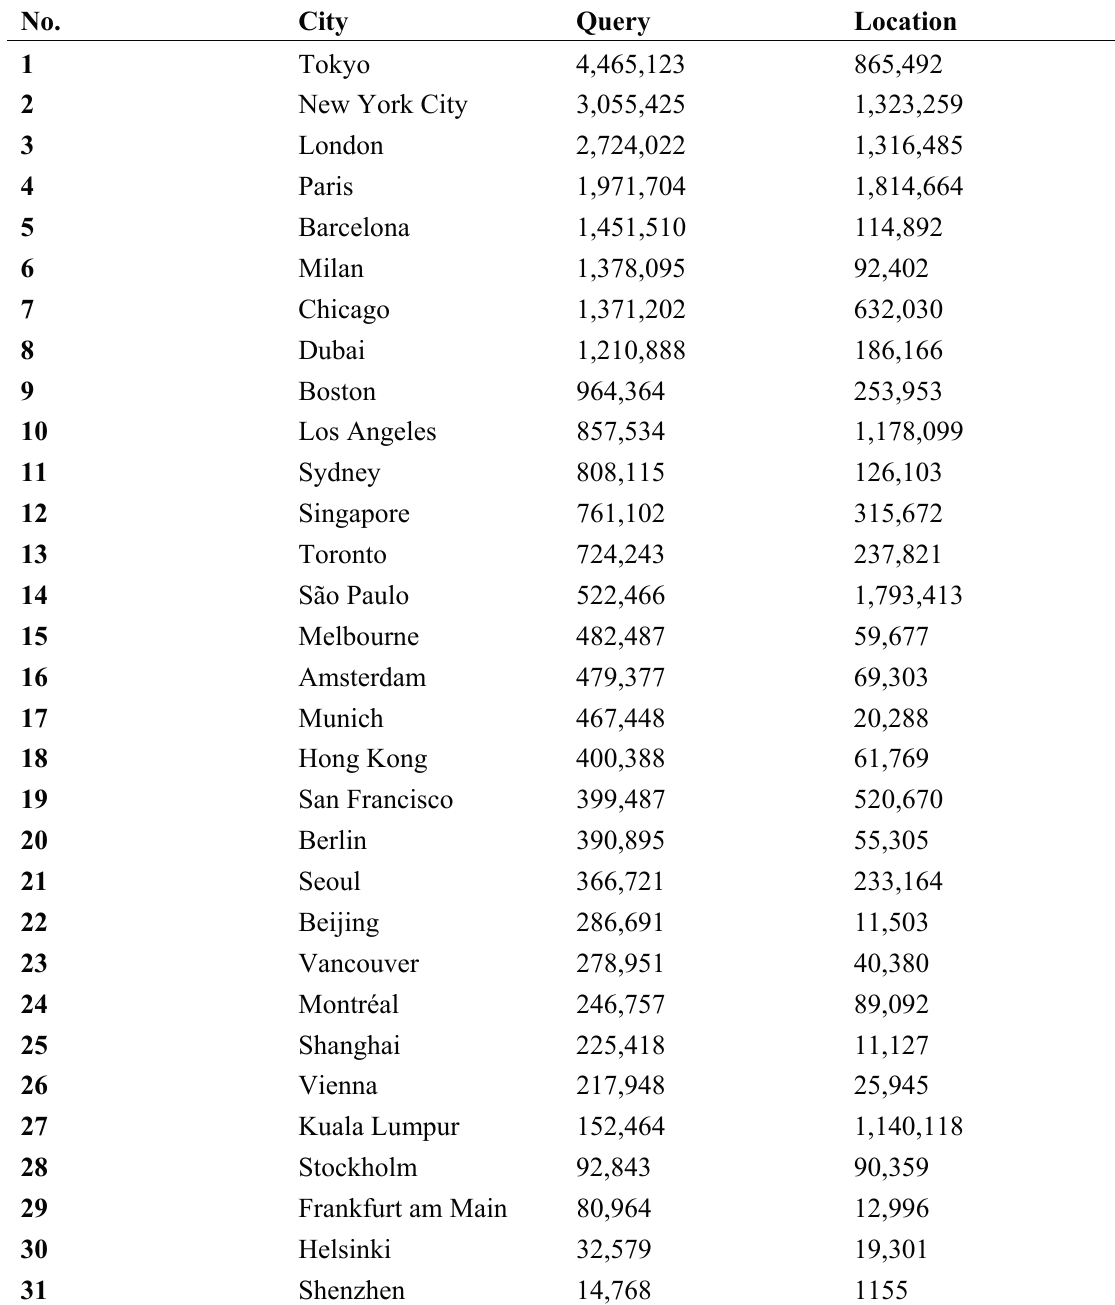
Table 1. Tweets per city ranked by the total amount of collected tweets between 2nd December 2013 and 16th December